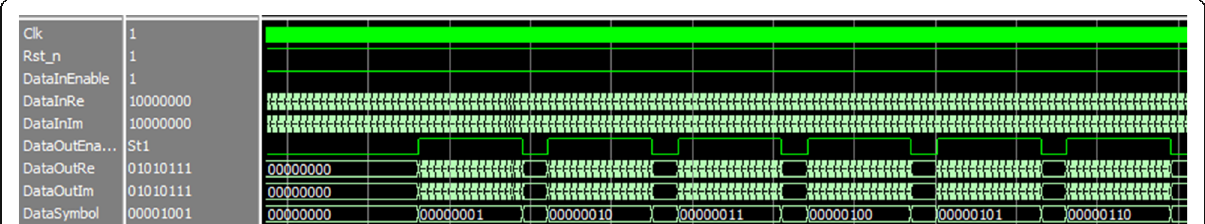
Fig. 7 The simulation diagram of frame synchronization. The simulation results of frame synchronization. DataOutEn is the effective time for outputting one symbol, which calculates from the long